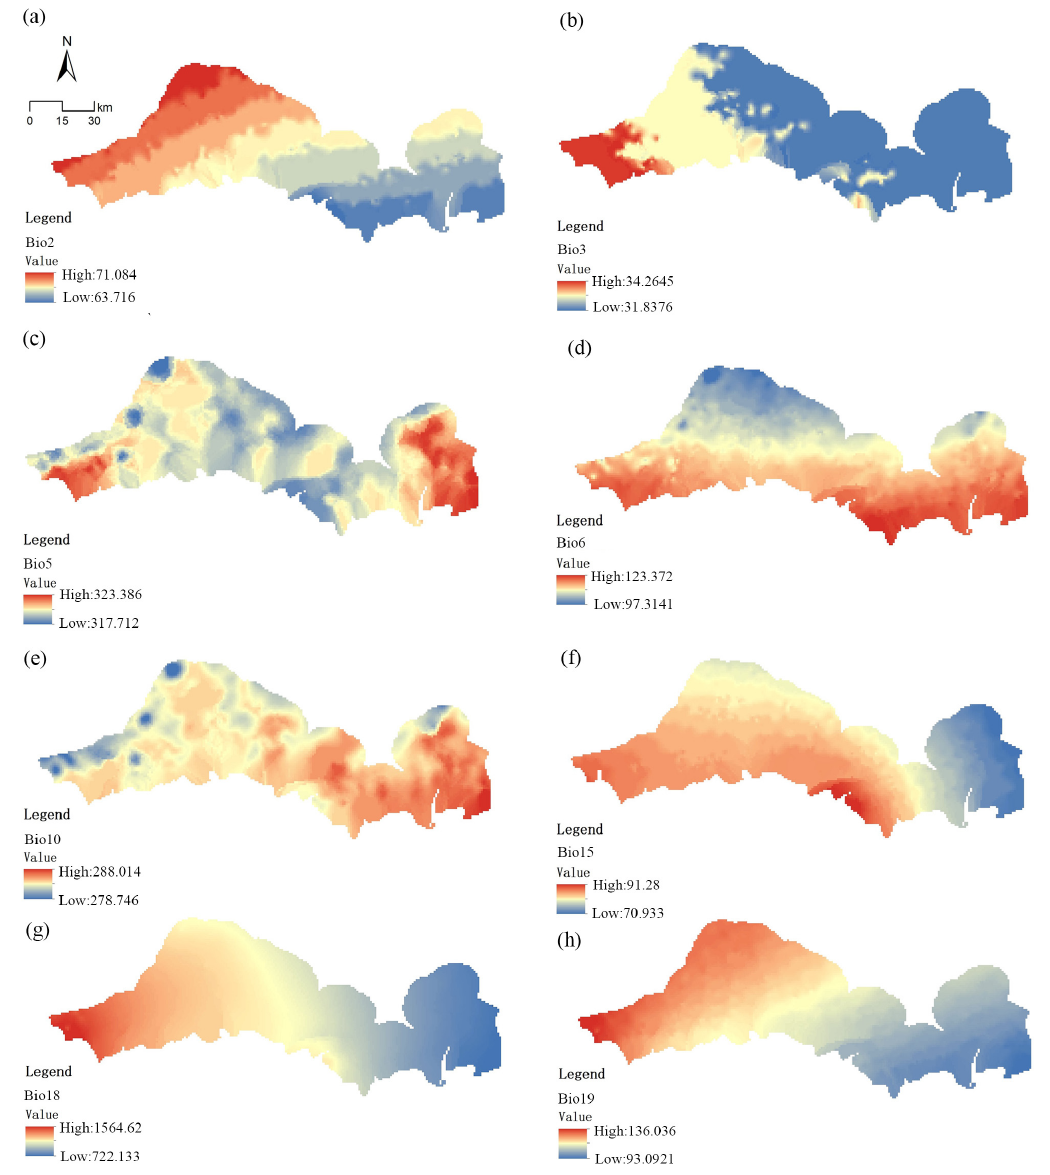
Figure 3. Environment variable. ( a ) Bio2, ( b ) Bio3, ( c ) Bio5, ( d ) Bio6, ( e ) Bio10, ( f ) Bio15, ( g ) Bio18, ( h ) Bio19.